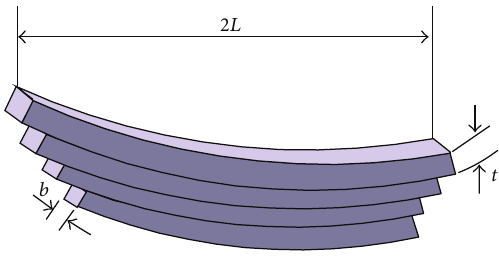
Figure 3: Elements of leaf spring.